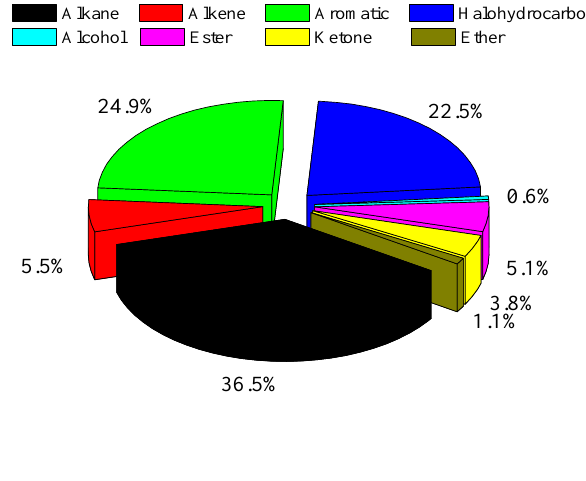
Figure 4. Measured VOCs in the morning (06:00–09:00) for different VOC groups (alkane, alkene, aromatic, halohydrocarbone, alcohol, ester, ketone, and ether) during July 2007–February